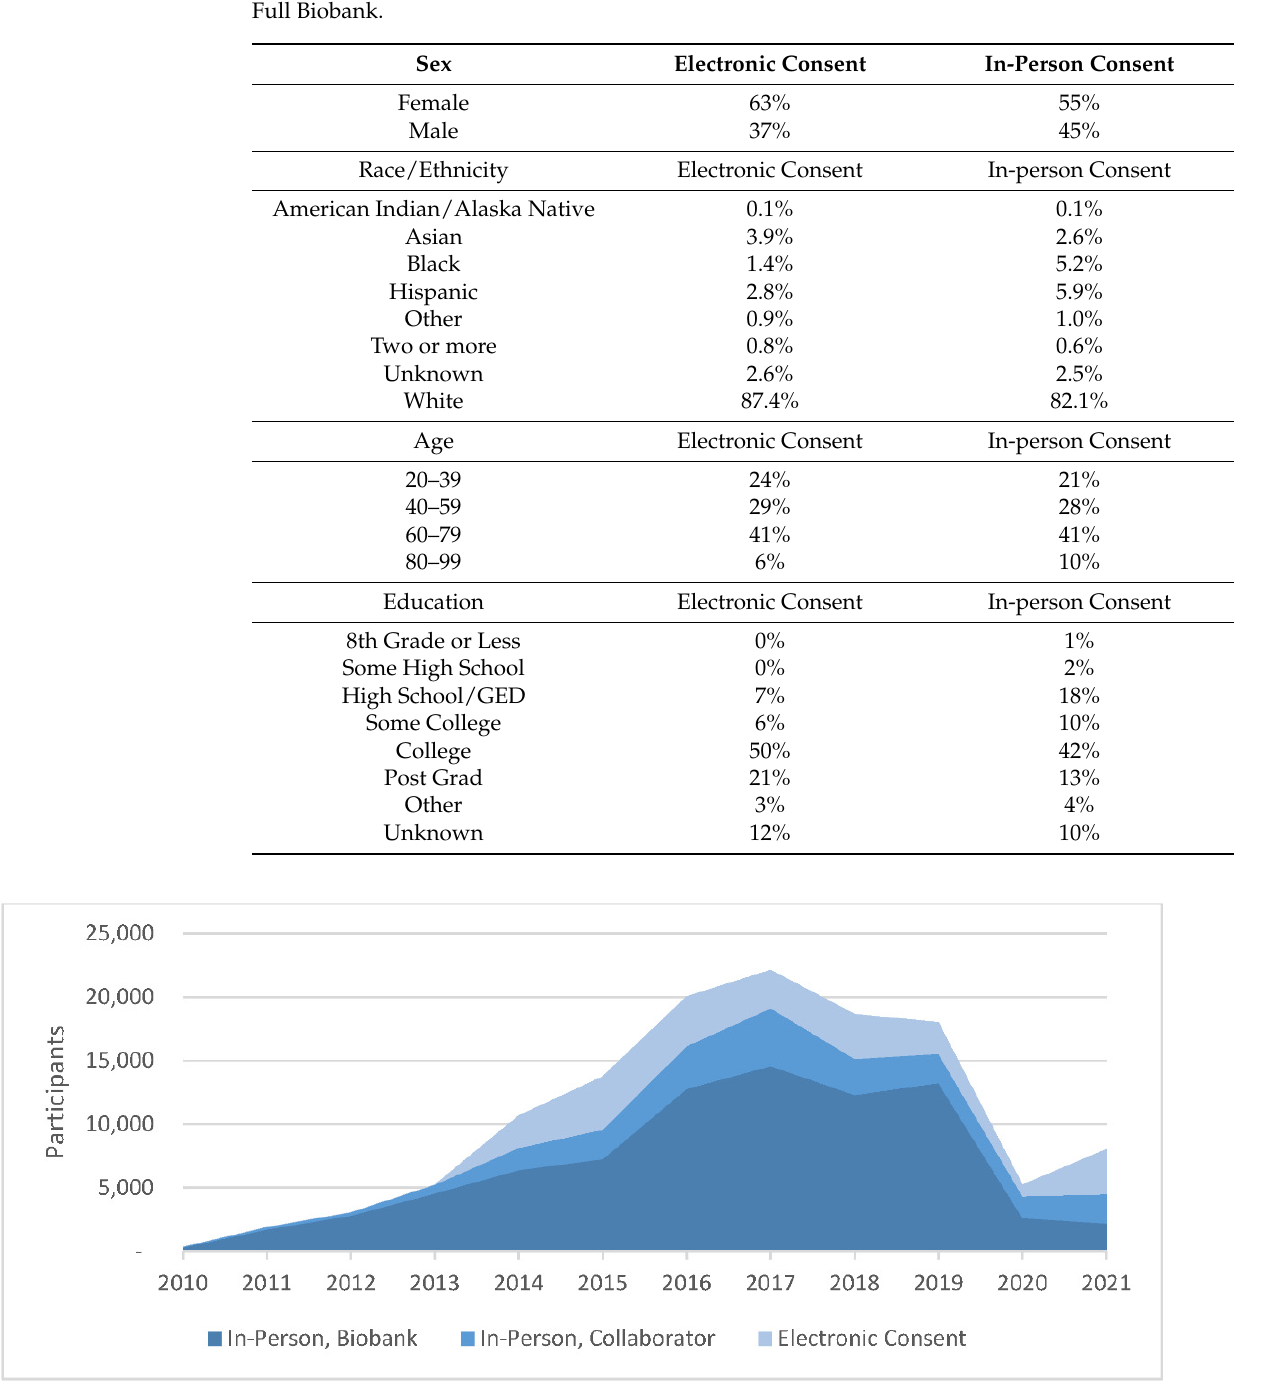
Figure 1. Consent by Recruitment